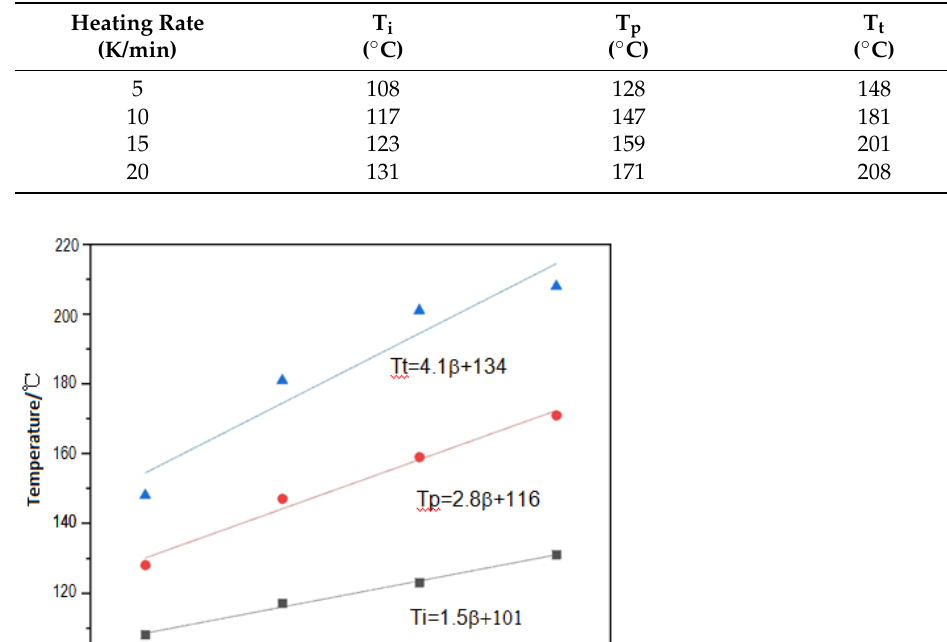
Table 2. Corresponding data of DSC curves at different heating rates.